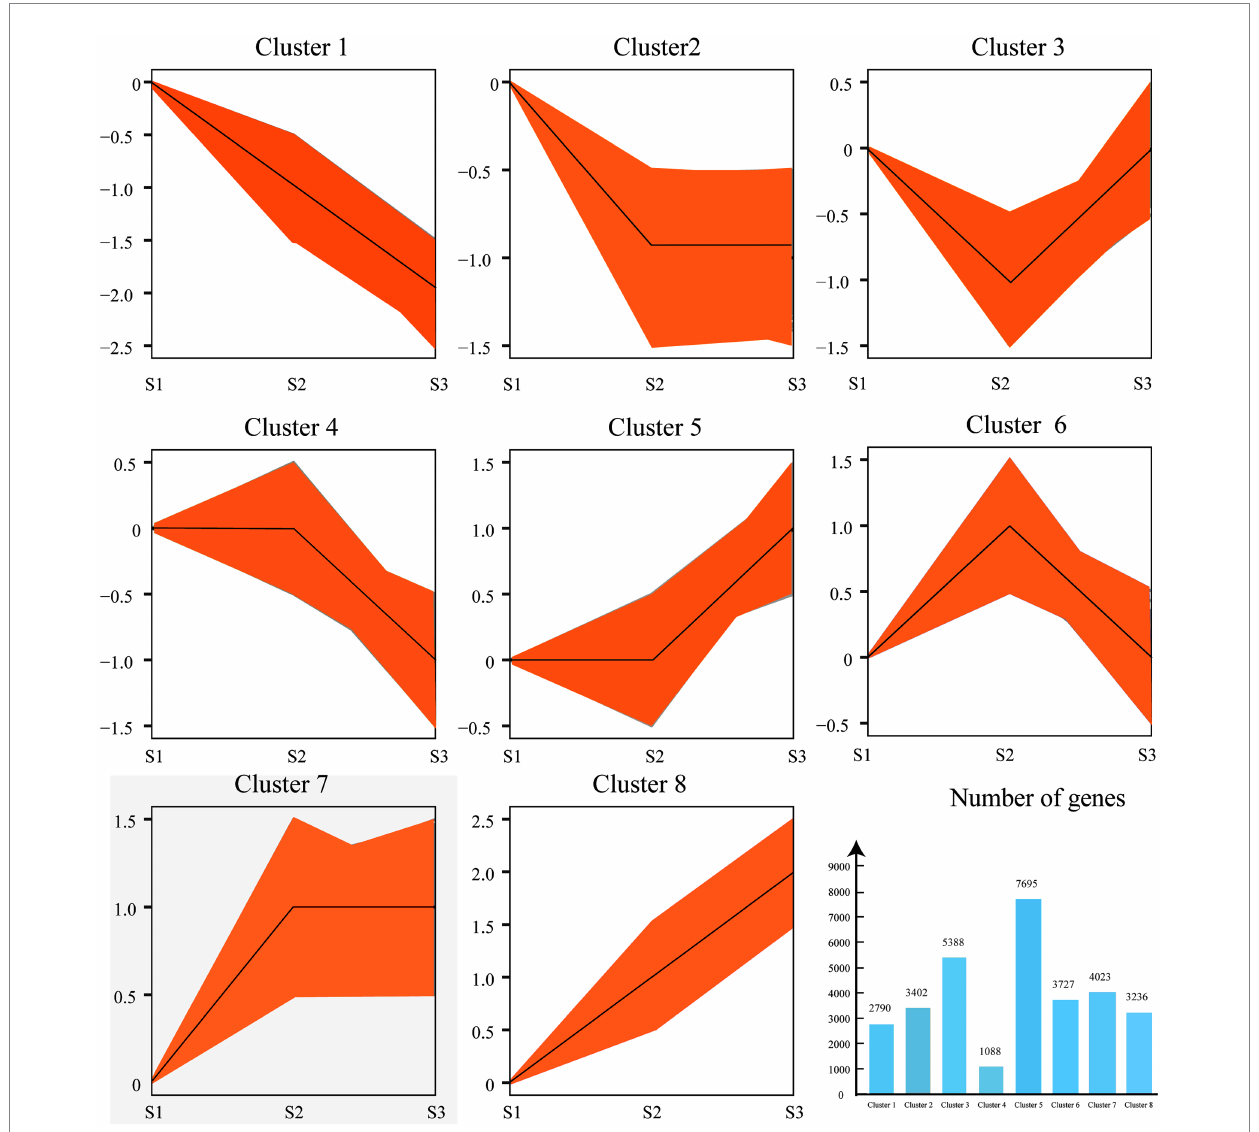
FIGURE 4 Clustering of gene expression profiles from chayote fruits during storage. The k-means method was used to perform the cluster analysis of gene expression profiles. The number of DEGs in each cluster. The X -axis and Y -axis represent the different samples and normalized FPKM of